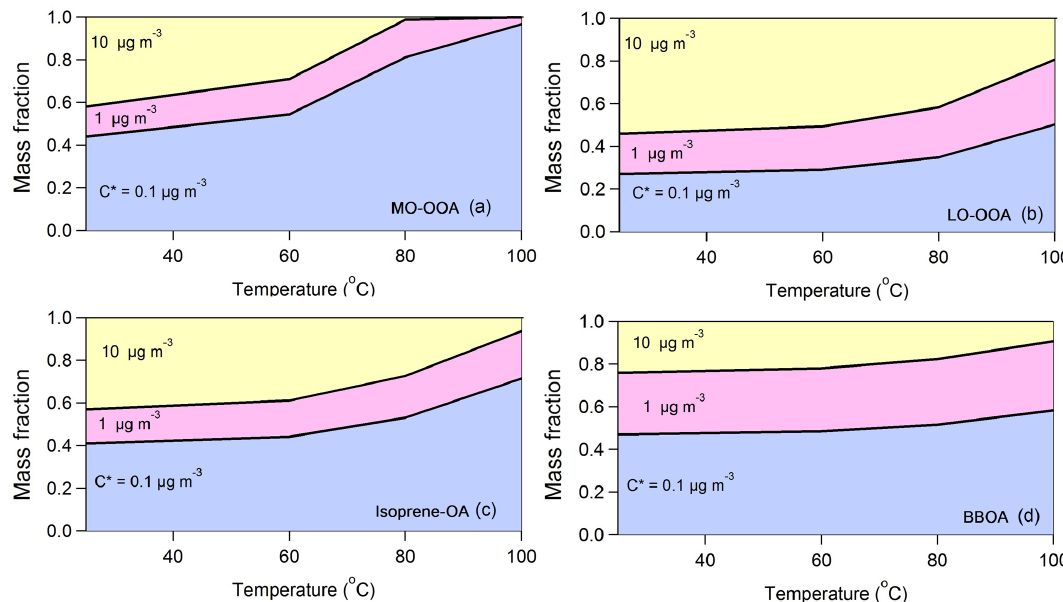
Figure 4. The predicted composition in terms of C ∗ for (a) MO-OOA, (b) LO-OOA, (c) isoprene-OA and (d) BBOA after passing through the thermodenuder as a function of the temperature. The model predicts, as expected, that the less volatile material with C ∗ = 0.1µgm − 3 dominates the composition of the remaining aerosol after the TD as the temperature increases for all factors. However, there are significant differences in the evolution of the composition of the various